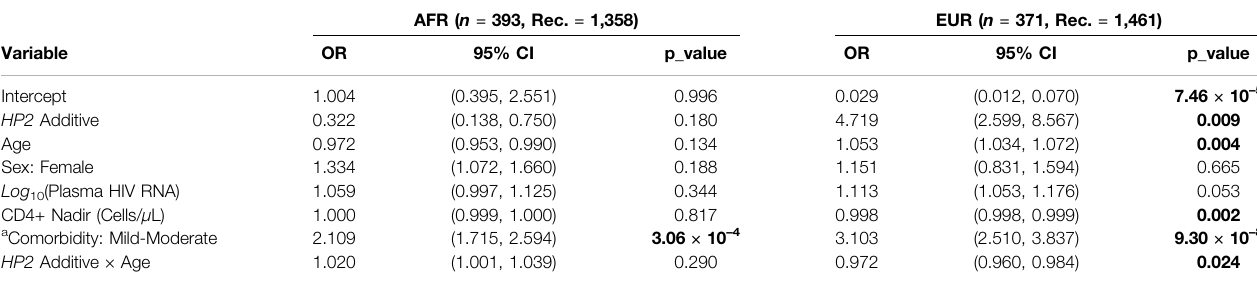
TABLE 4 | HP2 additive effect on NCI in the AFR and EUR participants over time. AFR ( n = 393, Rec. = 1,358) EUR ( n = 371, Rec. = 1,461) Variable OR